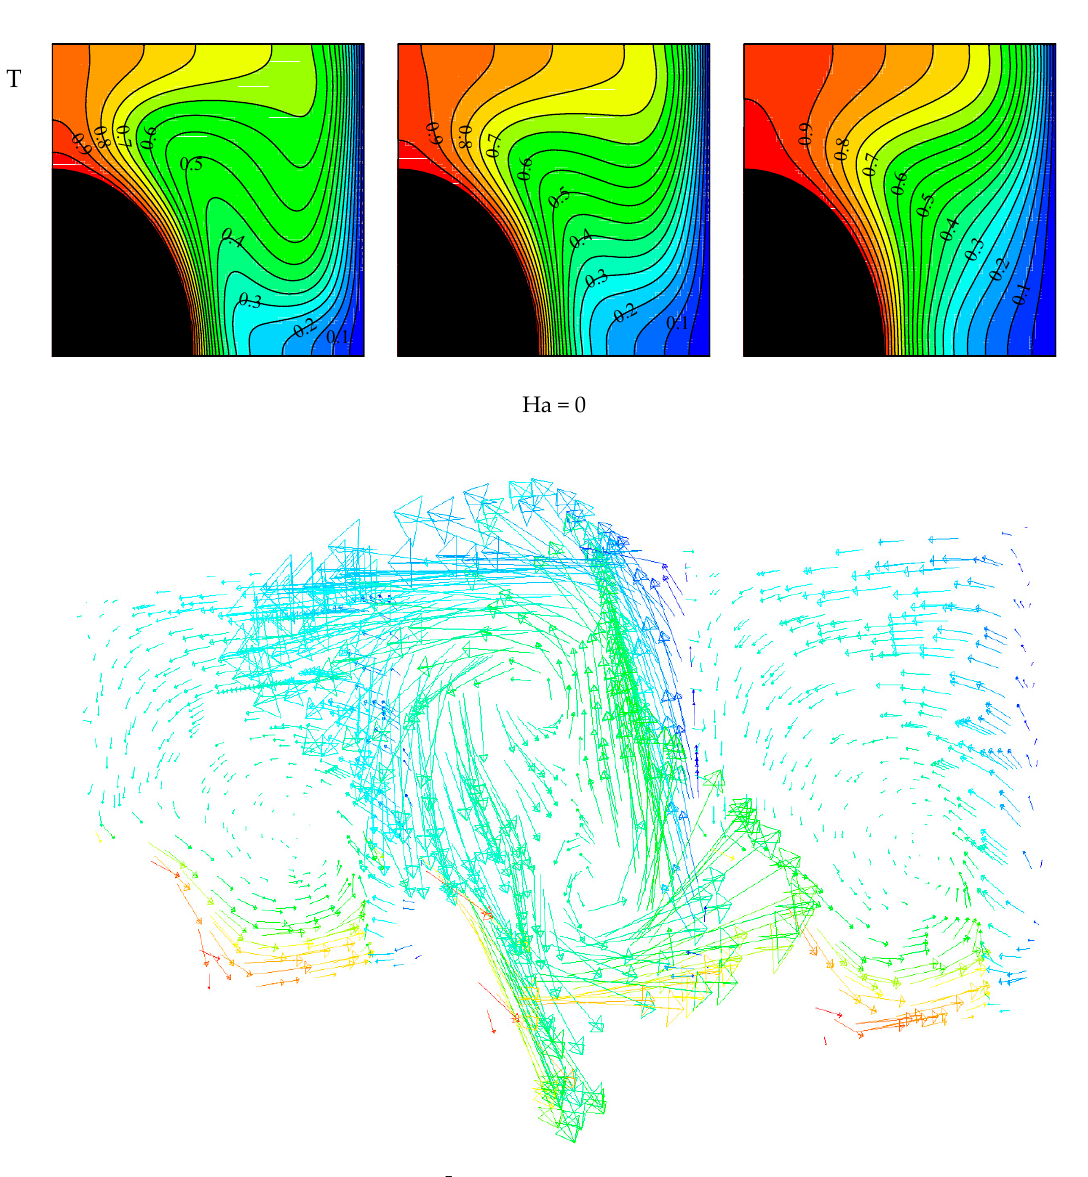
Figure 7. Stream and isothermal lines for Ra = 10 5 , Rd = 1, AR = 0.45 − 0.6, γ = 45, ω = 0, ϕ = 0.03, and various Ha values.